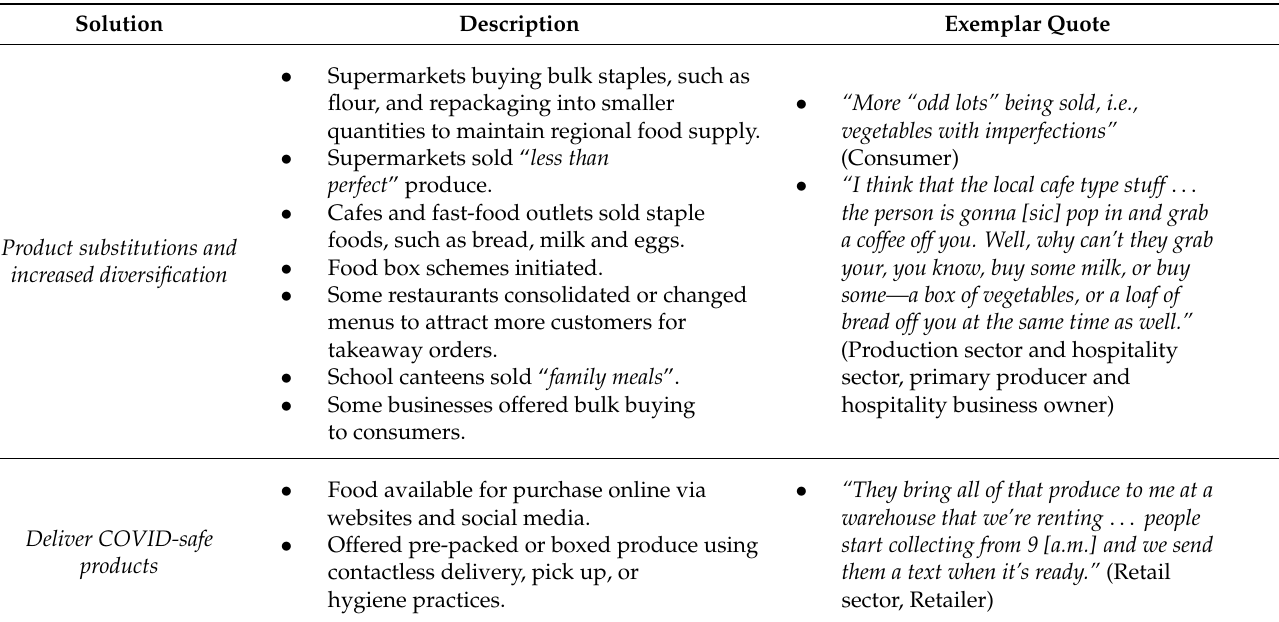
Table 3. Food business and supply solutions during the COVID-19 pandemic reported by consumer and food supply